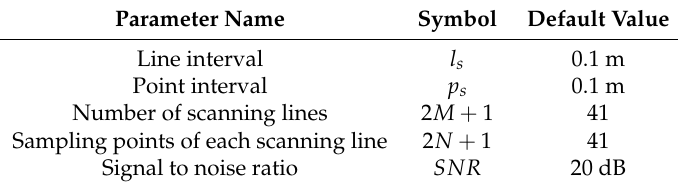
Table 4. Data collection simulation parameters and default